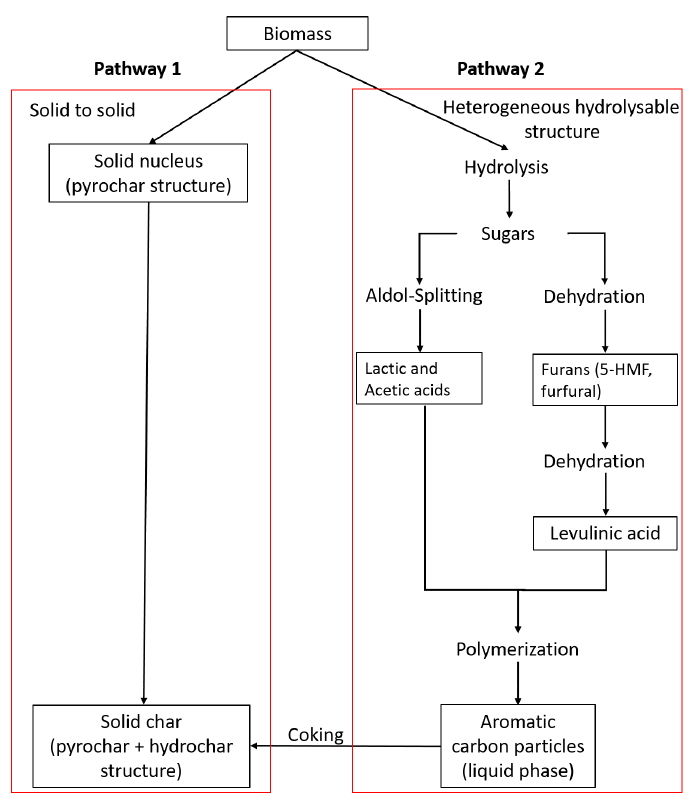
Figure 1. Possible char formation pathways of biomasses (e.g., spent sugar beets (SPB)) during hydrothermal treatment (HT); modified from Kruse et al. and Karaldiyrim [19,20].